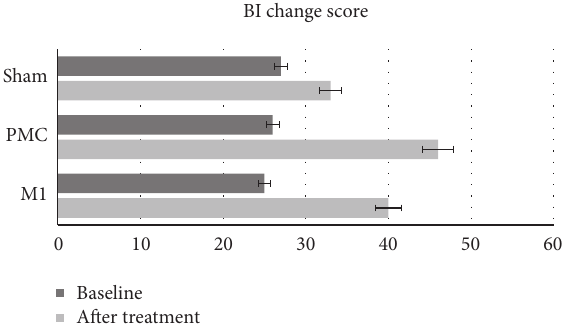
Figure 3: Comparisons of tDCS effects and CIMT on functional independence.